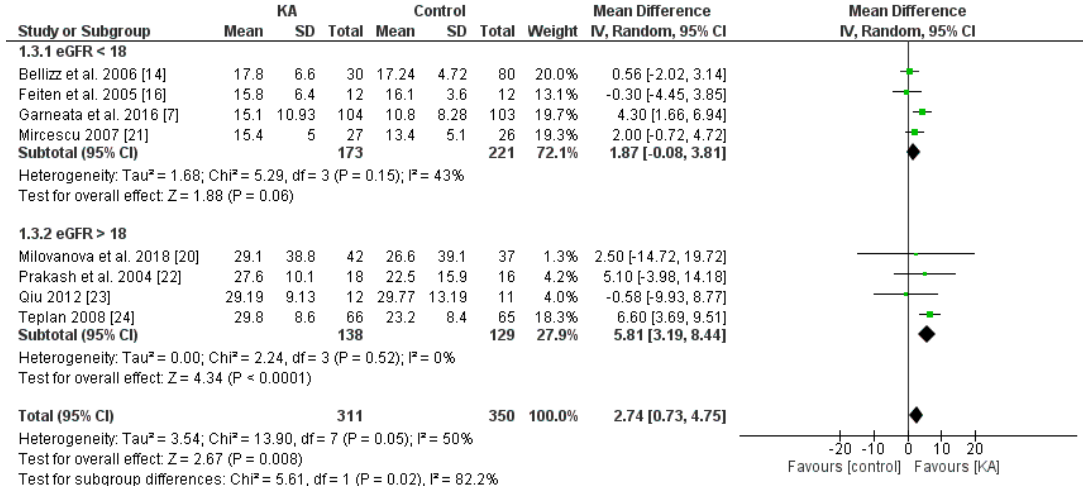
Figure 3. Forest plot of effects of KA on eGFR in CKD patients sub-grouped by the type of restricted protein diet. The random-effects model was utilized. KAVLP: very-low-protein diet supplemented with ketoanalogues. KALP: low-protein diet supplemented with ketoanalogues. LP: low-protein diet.